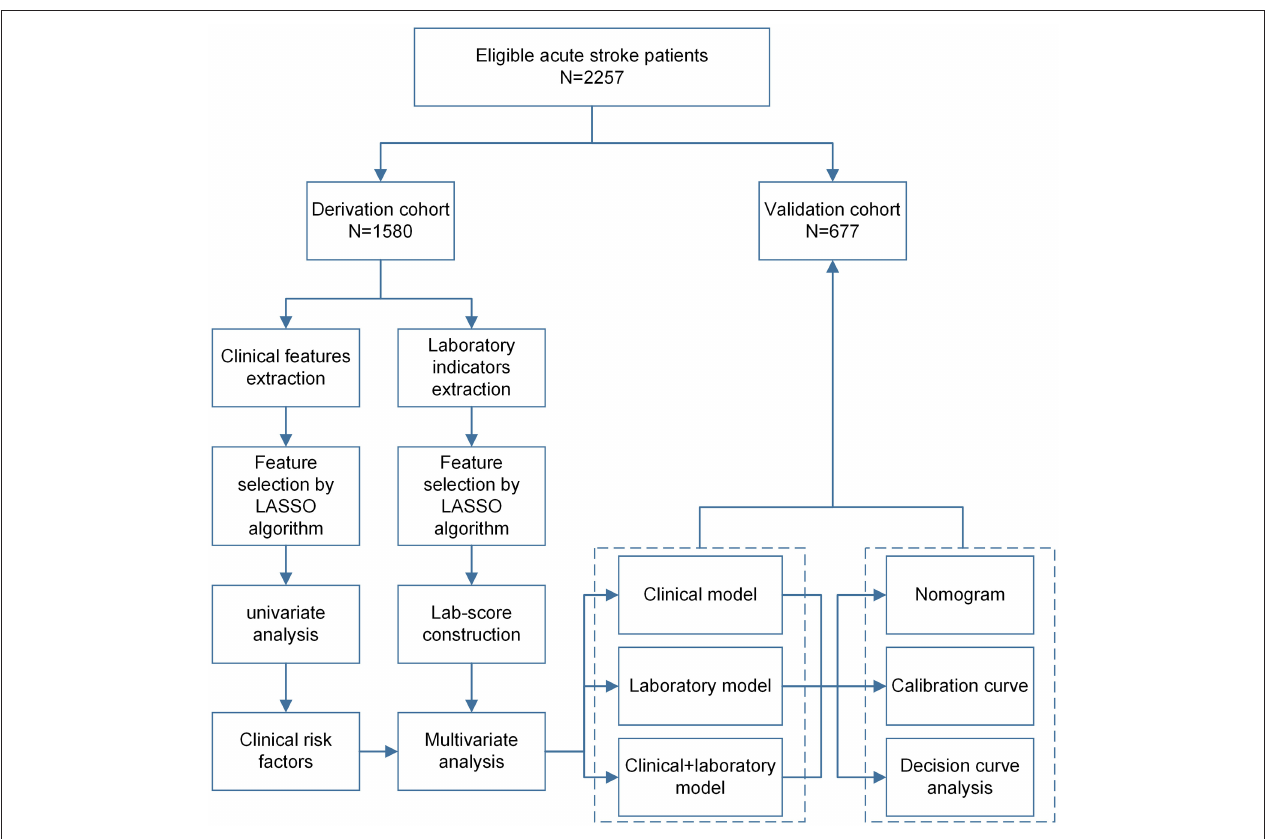
FIGURE 1 | The workflow of this study. LASSO, least absolute shrinkage and selection